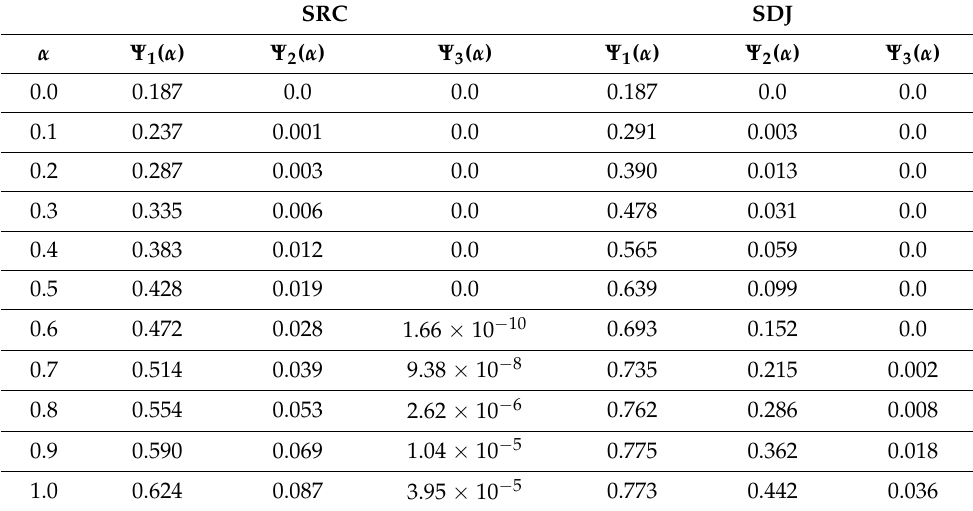
Table 1. Coefficients for dual-filter solutions